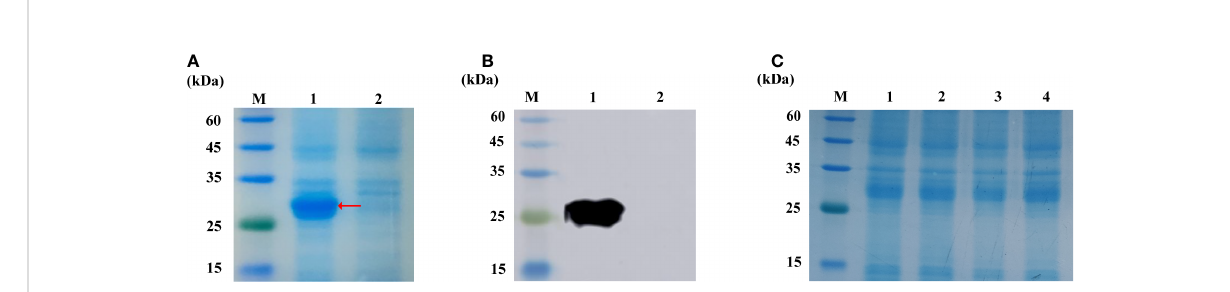
FIGURE 1 Expression and activity veri fi cation of Cihep. (A) Analysis by SDS-PAGE. M=protein marker; 1= pGEX-KG-hepcidin after overnight induction; 2= pGEX-KG-hepcidin before induction. (B) Western blotting assay of anti-GST antibody. M=protein marker; 1= pGEX-KG-hepcidin after overnight induction; 2= pGEX-KG-hepcidin samples before induction. (C) Protein lyophilized powder stability at -20°C. M=protein marker; 1, 2, 3, 4= represent D1, D7, D14 and D28